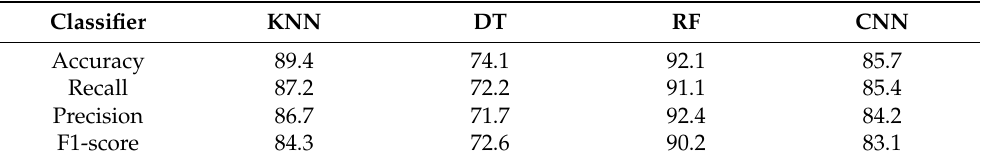
Table 8. Phase 2: Anomaly detection results in Scenario C: Set of mouse movement and point-and- click